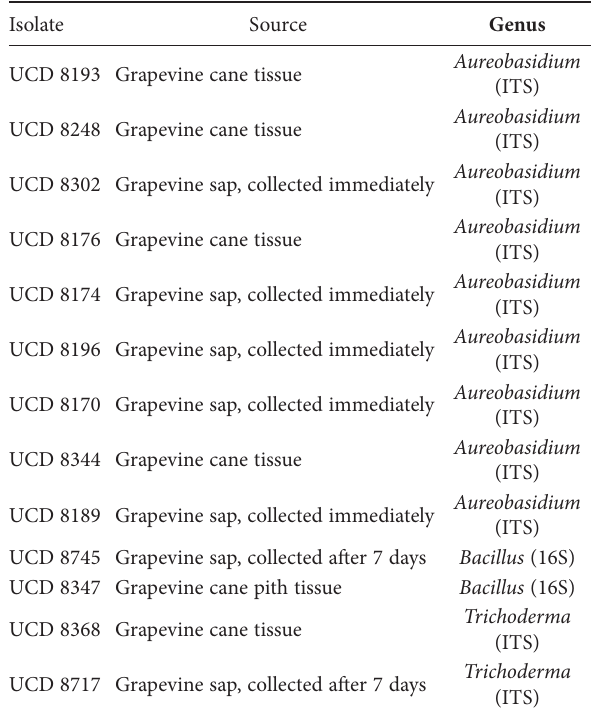
Table 1. Sources of isolated microorganisms and their